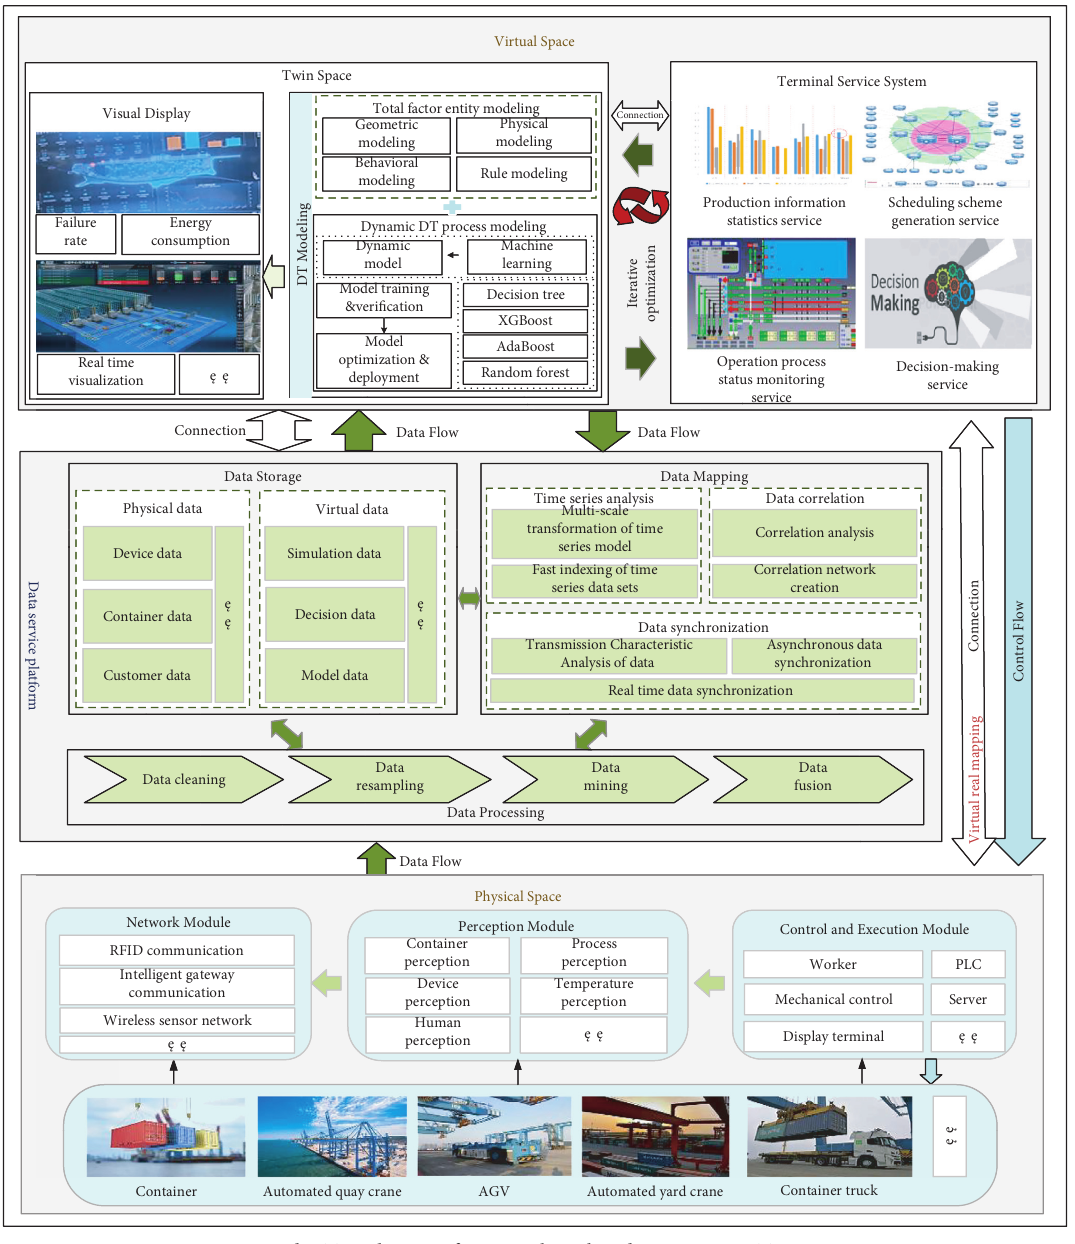
Figure 2: An integrated DT application framework with AdaBoost in ACT operation